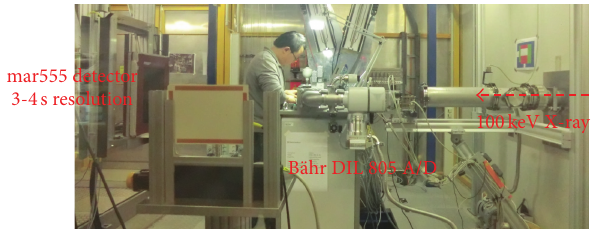
Figure 5: The configuration of X-ray beam, experimental equip- ment, and 2-dimensional detector in the experimental hutch during theinsituhighenergyXRDmeasurementattheengineeringmateri-